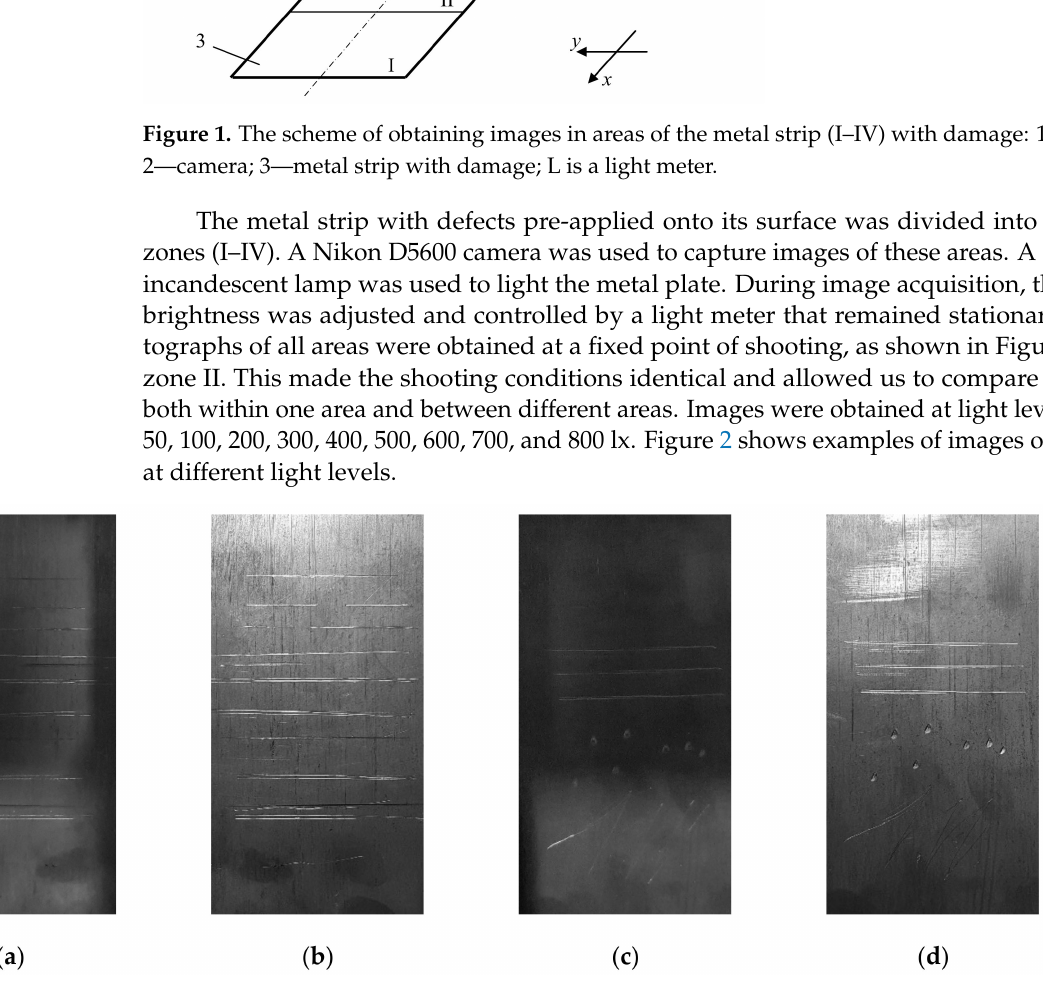
Figure 2. Images of damage in zones I ( a , b ) and II ( c , d ) at two light levels: 2 lx ( a , c ) and 600 lx ( b , d